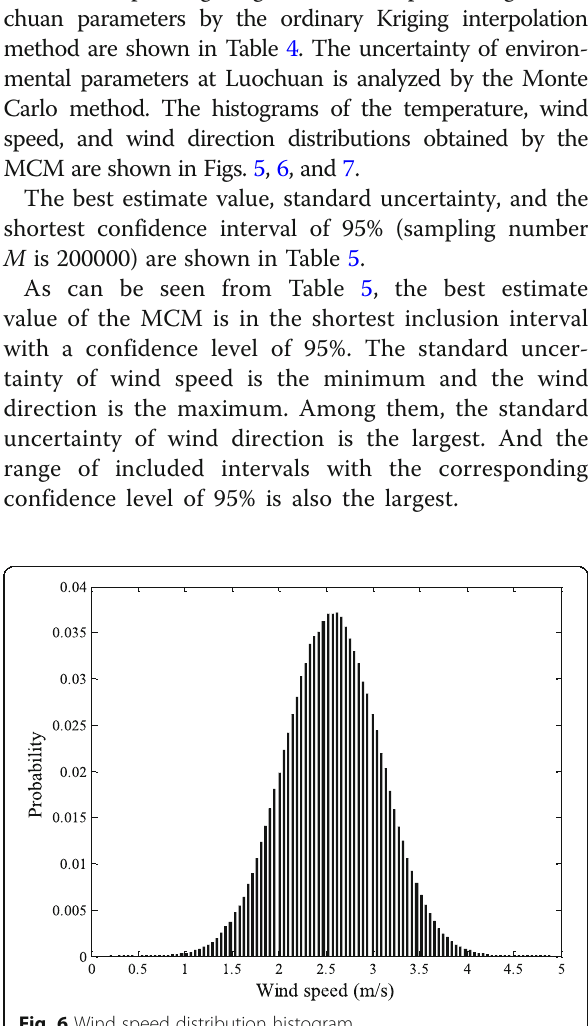
Fig. 6 Wind speed distribution histogram